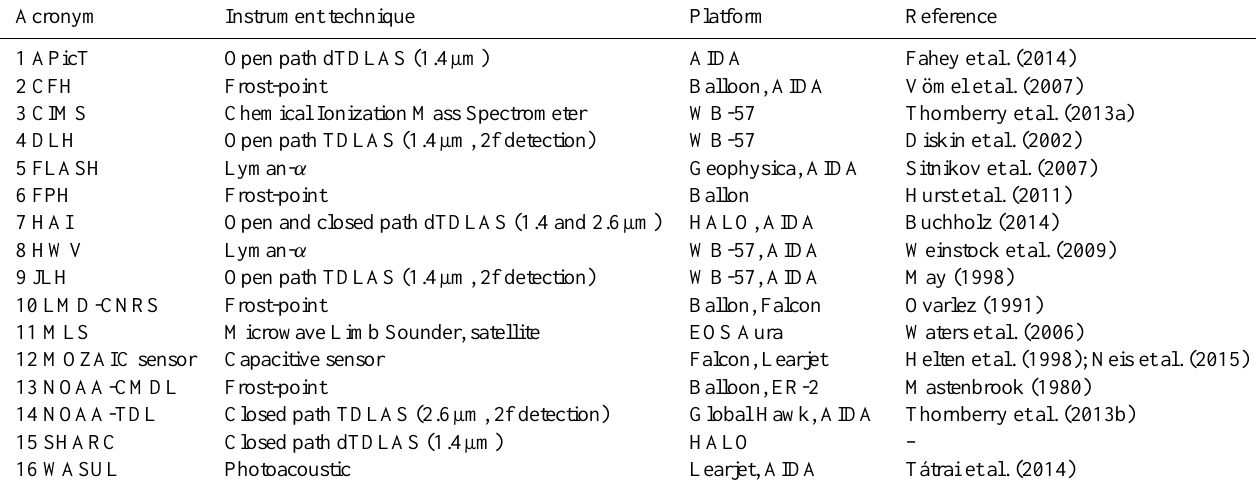
Table 2. List of instruments compared with